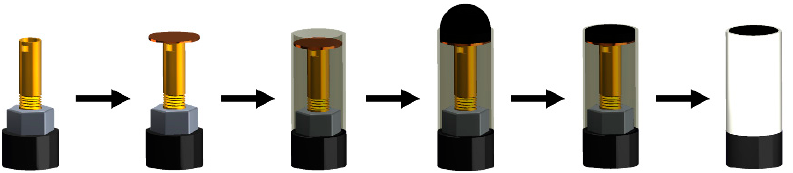
Figure 1. Scheme of the mechanic assembly for the construction of the base graphite-epoxy voltam- metric transducer.